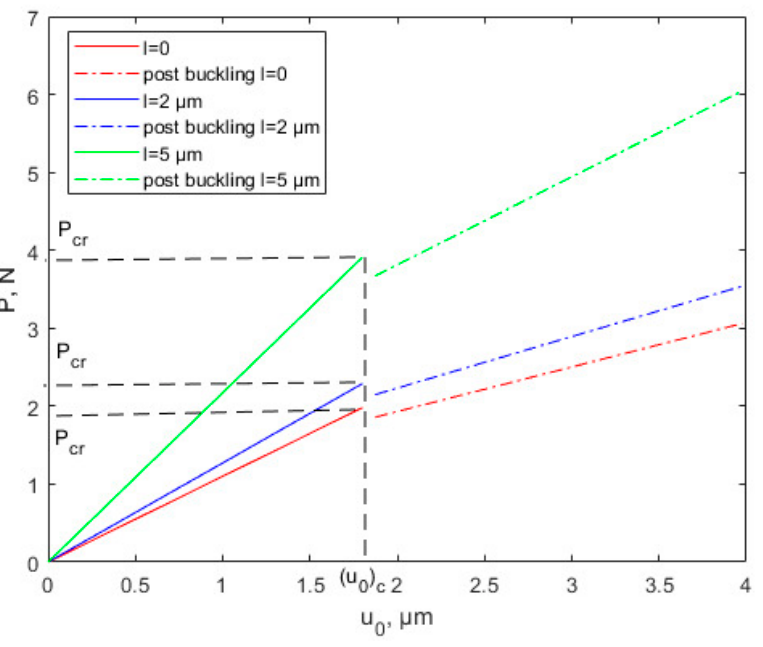
Figure 3. Pre-buckling and linear post-buckling responses of thin Cu plate based on CT and MCST. Table 2. Cu and Al plate flexural stiffness between pre-buckling and post-buckling based on CT and MCST.